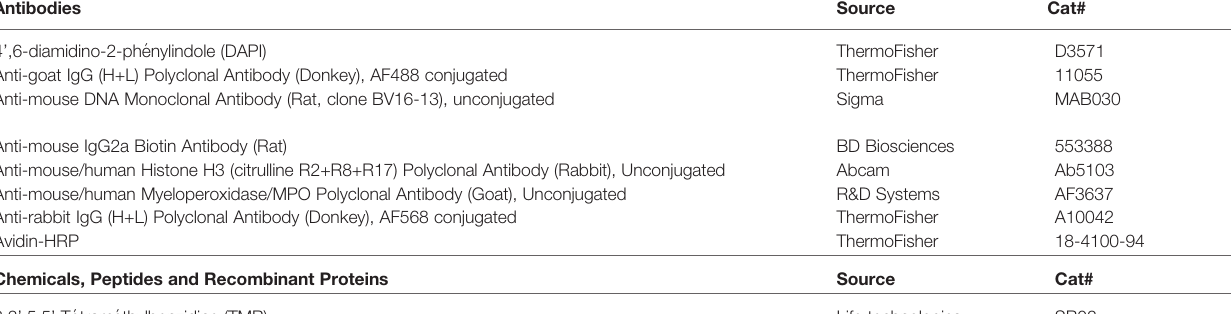
TABLE 3 | List of antibodies, reagents and software used in this study.